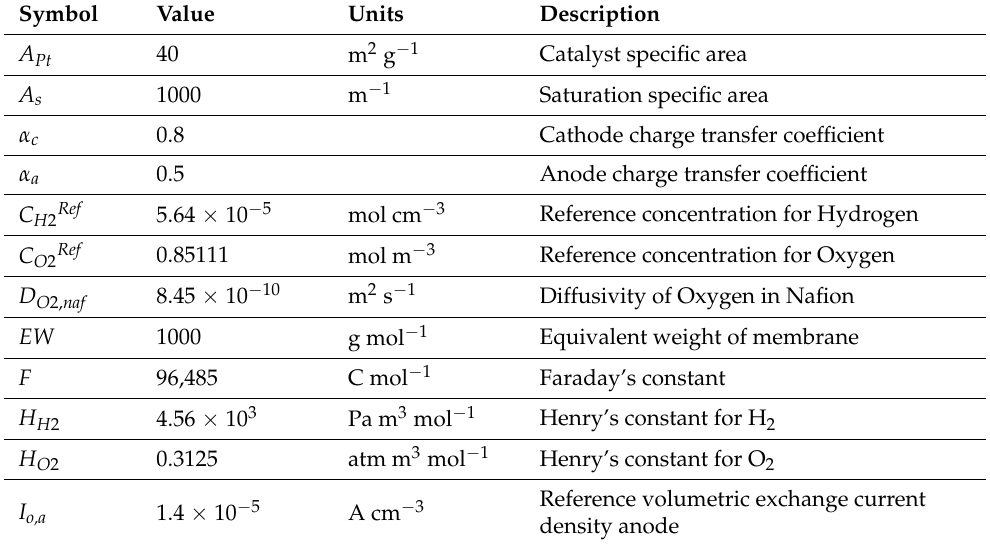
Table 4. Modeling parameters used for the model